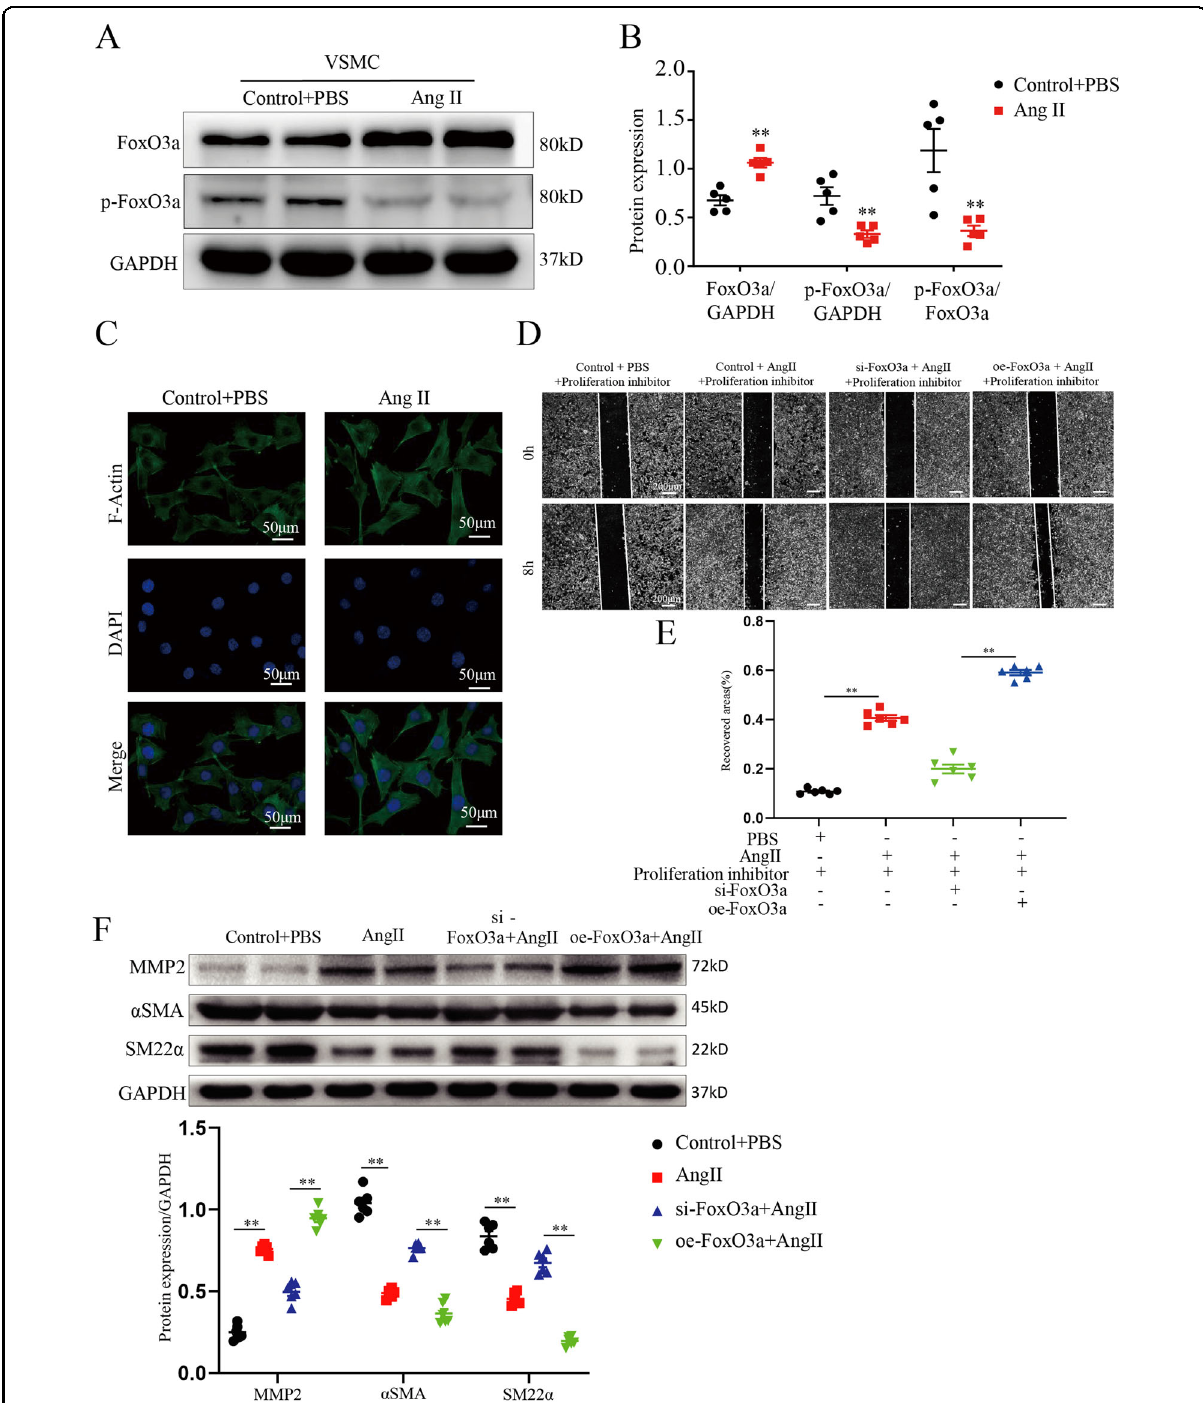
Fig. 3 FoxO3a expression is upregulated during the phenotypic switch induced by Ang II in vitro. A and B WB and densitometric analysis of the protein levels of FoxO3a and p-FoxO3a in VSMCs treated with Ang II for 24 h (1 μ mol/L; n = 6). C Representative pictures of VSMCs stained with actin-tracker green (treated with Ang II for 24 h; 1 μ mol/L; DAPI, blue; actin-tracker green, green). D and E Wound scratch assay was performed to assess VSMC motility and migration within VSMCs after Ang II administration and/or functional FoxO3a knockdown or overexpression (treated with Ang II for 0 h or 8 h; 1 μ mol/L). F WB and densitometric analysis of the protein levels of α -SMA, MMP2 and SM22 α within VSMCs after Ang II administration and/or functional FoxO3a knockdown or overexpression ( n = 6). Data are presented as the mean ± SE. * p < 0.05, ** p < 0.01. Control indicates VSMCs treated with PBS. oe, overexpression;